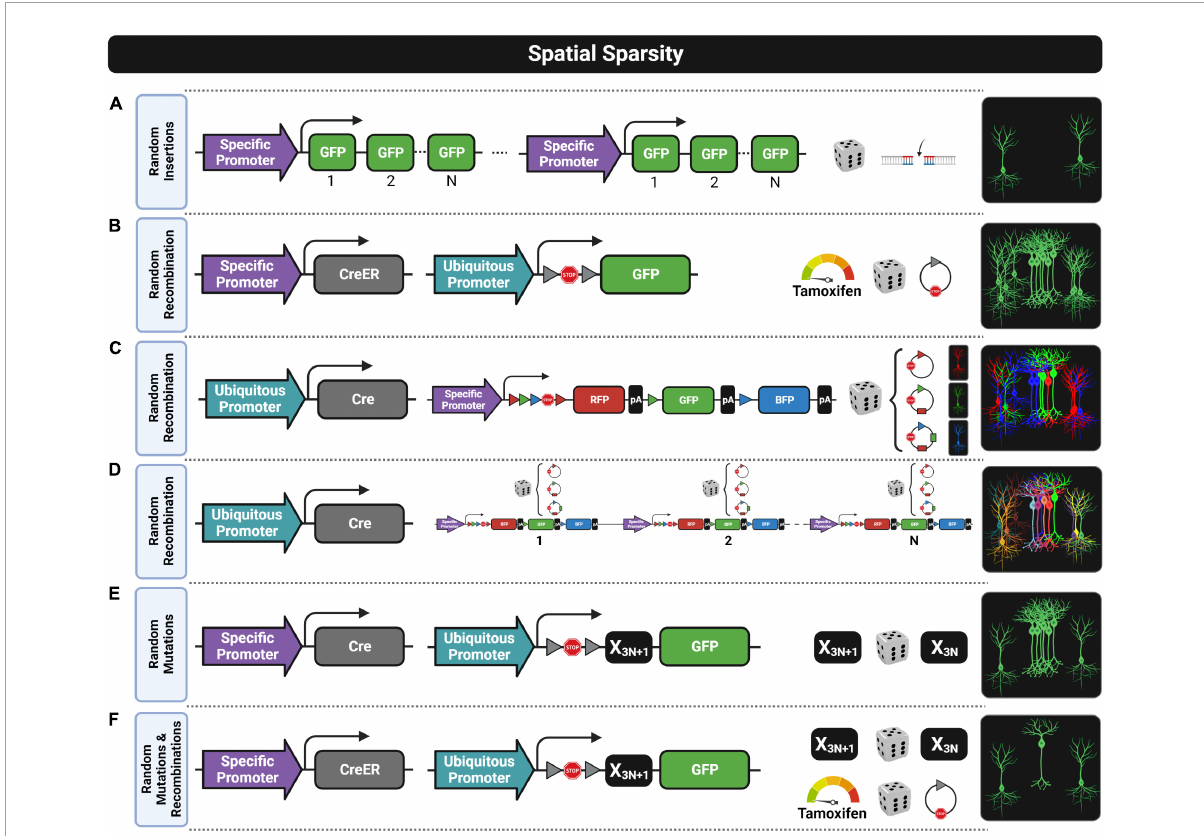
FIGURE3 Fluorescent transgenic designs for spatially sparse labeling. Six approaches are shown by depicting from left to right the construct designs, the stochastic process for achieving spatial sparseness, and labeling patterns. (A) Random insertions of the construct into the genome can result in spatially sparse labeling that is usually biased since some cell subtypes within the complete population genetically defined by a specific promoter are usually unlabeled due to epigenetic silencing events. (B) Random recombination achieved with a low Tamoxifen dose when using the CreER/LoxP design results in a still dense labeling pattern when selecting a promoter with widespread expression. (C) Random recombinations in the Brainbow construct lead to three chromatic labelings (e.g., red, green, and blue) that do not provide enough chromatic discrimination for extracting individual morphologies. (D) Random recombination in a design having multiple copies of the Brainbow construct provides multiple chromatic labeling (e.g., red–green–blue combinations) suitable for chromatic discrimination, but the brightness of the fluorescent labeling is usually not good enough for morphological reconstructions. (E) Random mutations in the mononucleotide repeat frameshift (MORF) design provide spatially sparse labeling with some clustering patterns where morphological reconstruction might not be possible. (F) Random mutations and random recombinations in the MORF design combined with CreER/LoxP design usually provide a good enough spatially sparse labeling that is usually suitable for morphological reconstruction even using a promoter with widespread